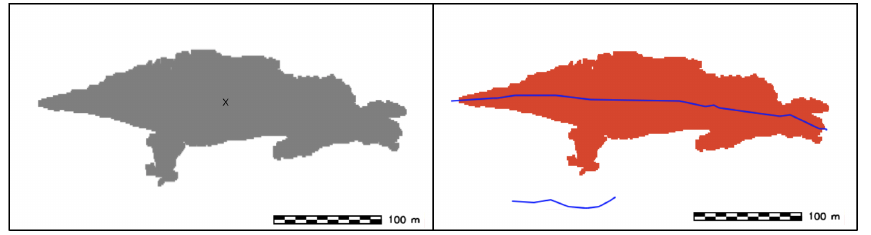
Figure 19. SW and SWC overlay.